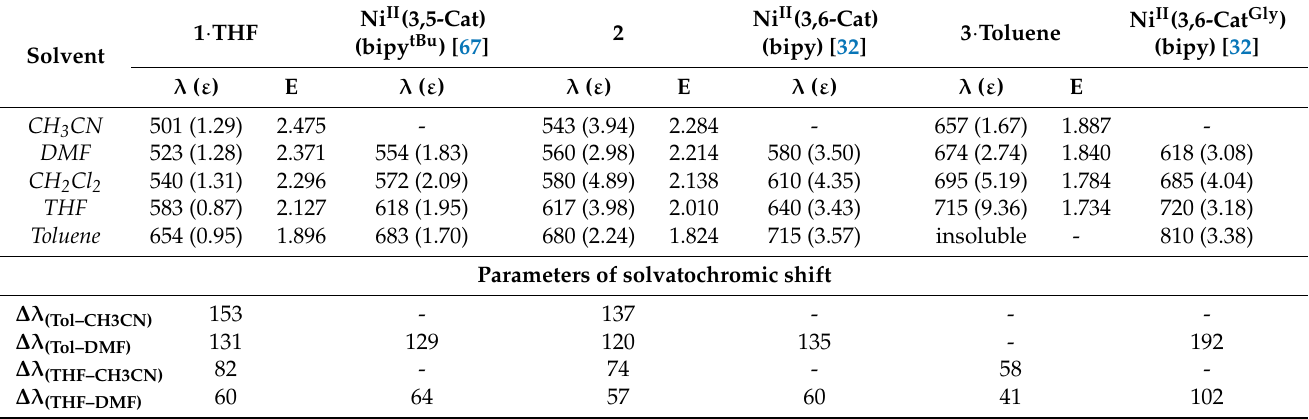
Table 5. The characteristics of the CT peaks for complexes 1 – 3 in comparison with related known